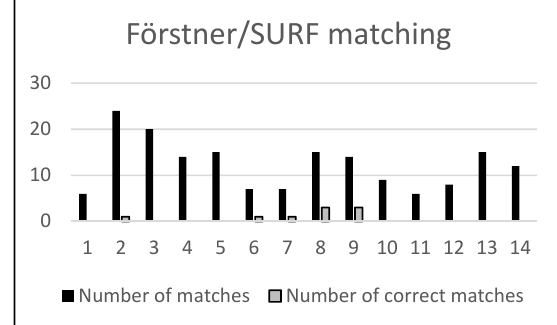
Figure 5. Matching results of Förstner detection and SURF description across all 14